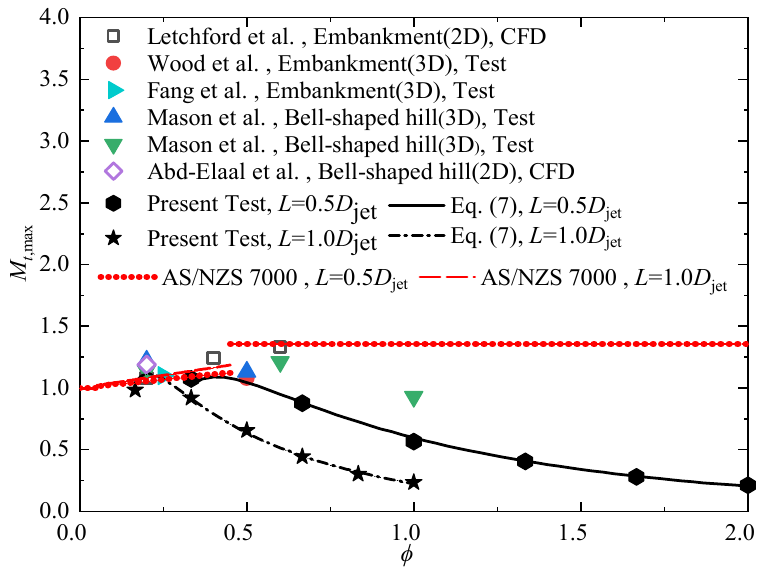
Figure 24. M t,max at